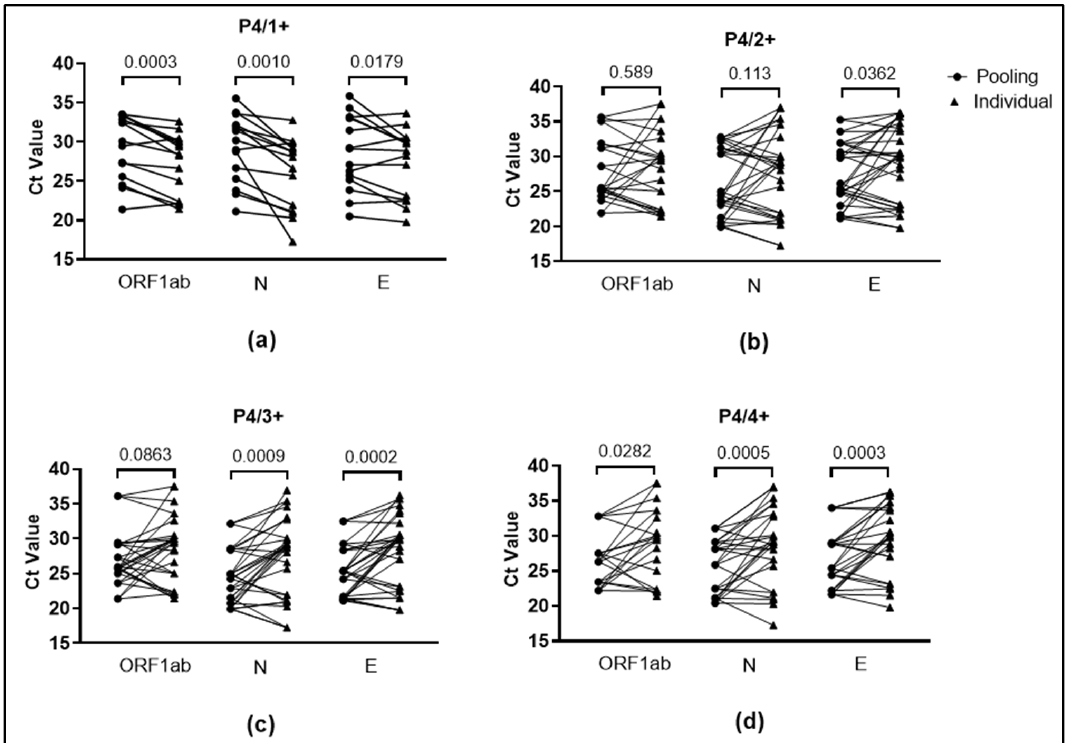
Figure 5. Comparison of pooled and individual specimens’ Ct values in the pooling-of-four method for each targeted gene. Ct value from 19 pools with one positive individual specimen ( a ); 16 pools with two positive individual specimens ( b ); 12 pools with three positive individual specimens; and ( c ); 7 pools with four positive individual specimens ( d ). Pooled Ct (black-colored circle) and corresponding individual Ct (black-colored triangle) are shown by connecting lines. p -value above plot graphs based on paired t -test.